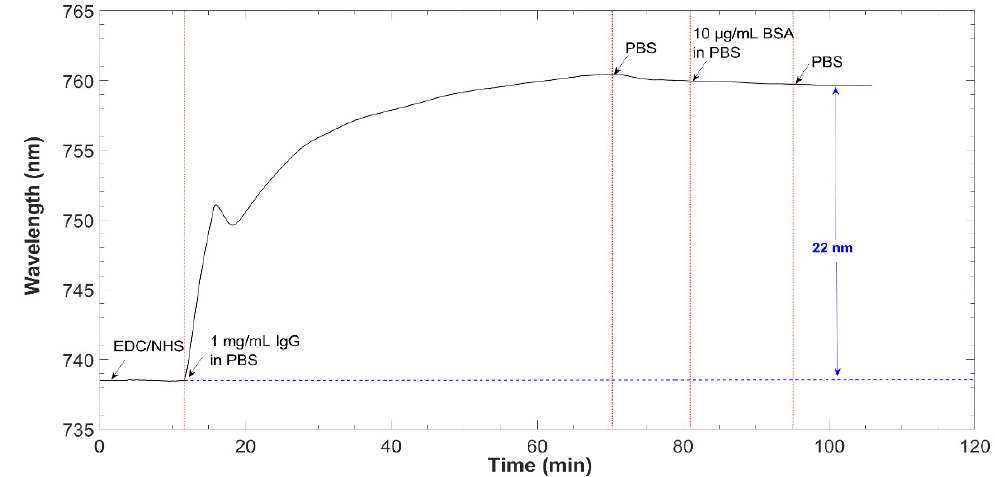
Figure 9. LMR central wavelength shift during IgG immobilization.